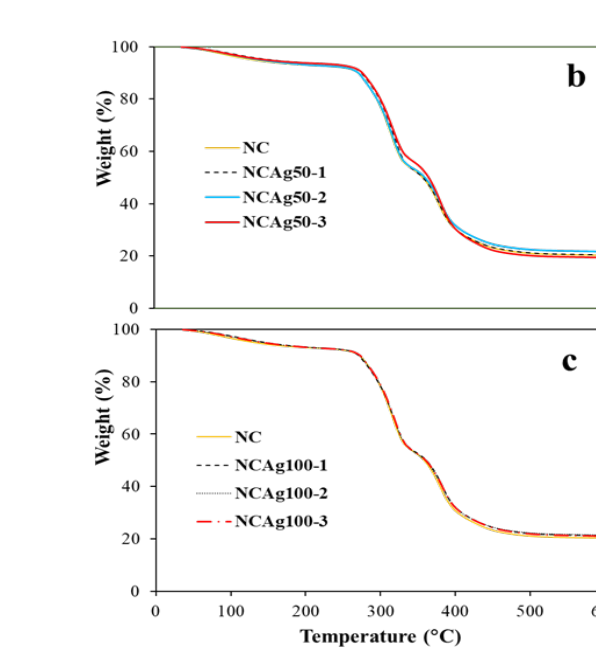
Figure 8. Biodegradation in soil of NC, NCAg50, and NCAg100 films after 2 weeks. The symbol * indicates a significant difference ( p < 0.05, n = 3) vs. NR films.